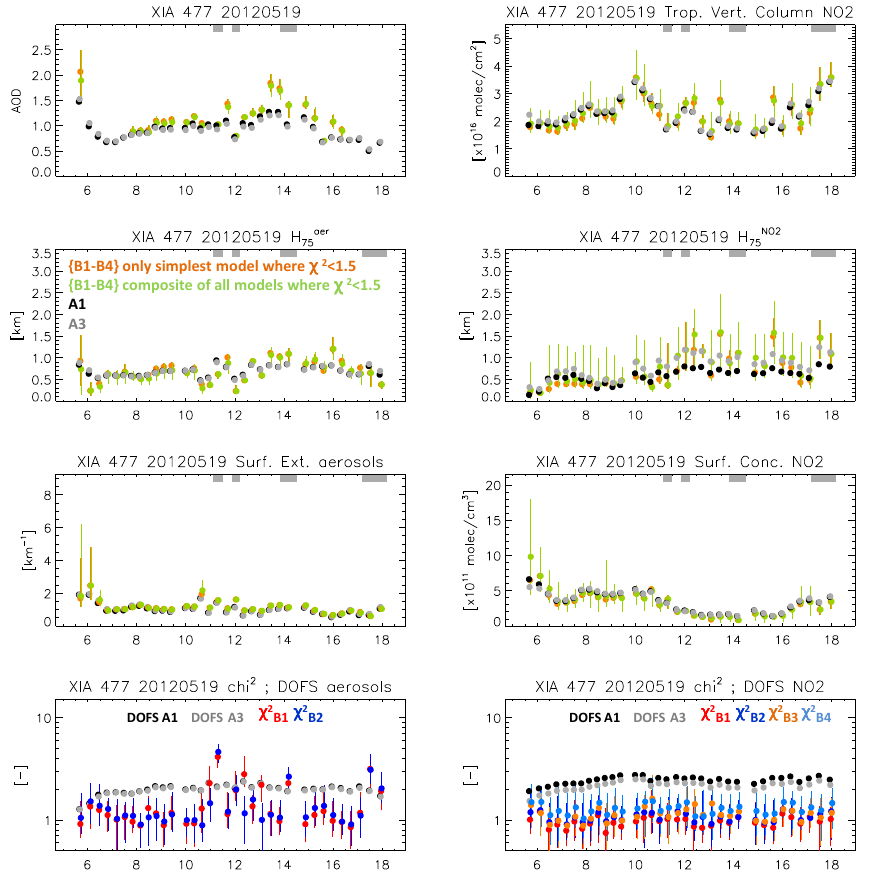
Figure 7. Example of quantities derived from the profile retrieval in the Vis (Xianghe, 19 May 2012). The left column shows the results of the aerosol retrieval, the right column shows results for the NO 2 retrieval. Grey horizontal bars above each panel indicate periods that are flagged because of high values of χ 2 in the aerosol or in the trace gas